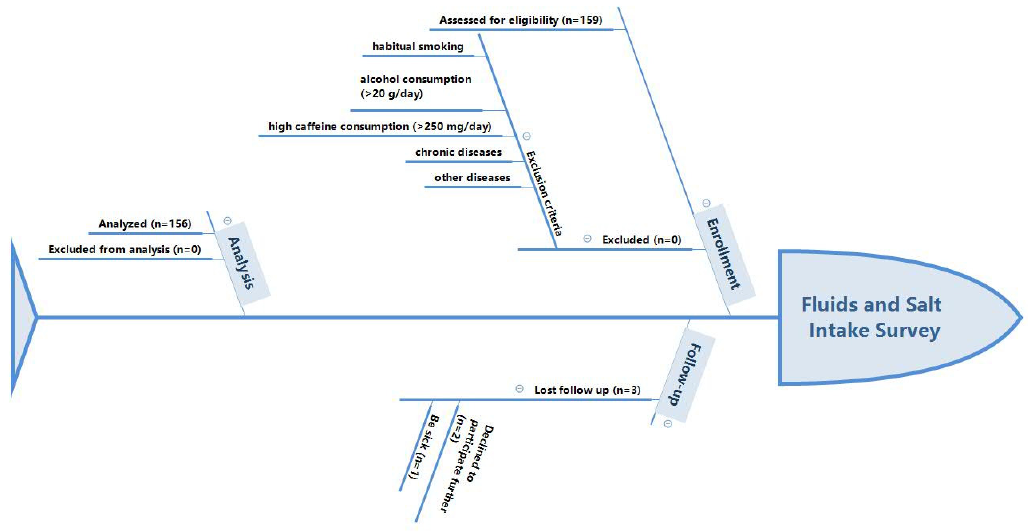
Figure 1. Participants flow chart.